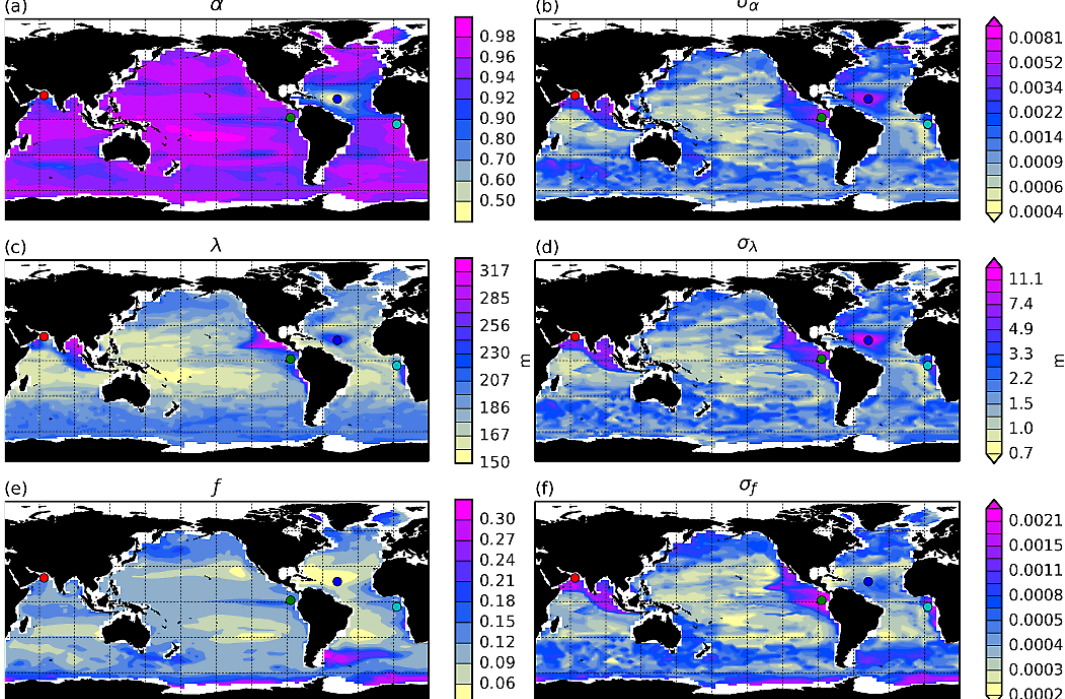
Fig. 5. Distribution of POC labile fraction ( α ), remineralization length scale ( λ ) and export ratio ( f ) (a, c, e) and their standard errors (b, d, f) obtained from fitting Eq. (1) to CCSM–BEC annual mean POC flux profiles and NPP at each model grid point. The colored circles mark the location of the vertical profiles shown in Fig.